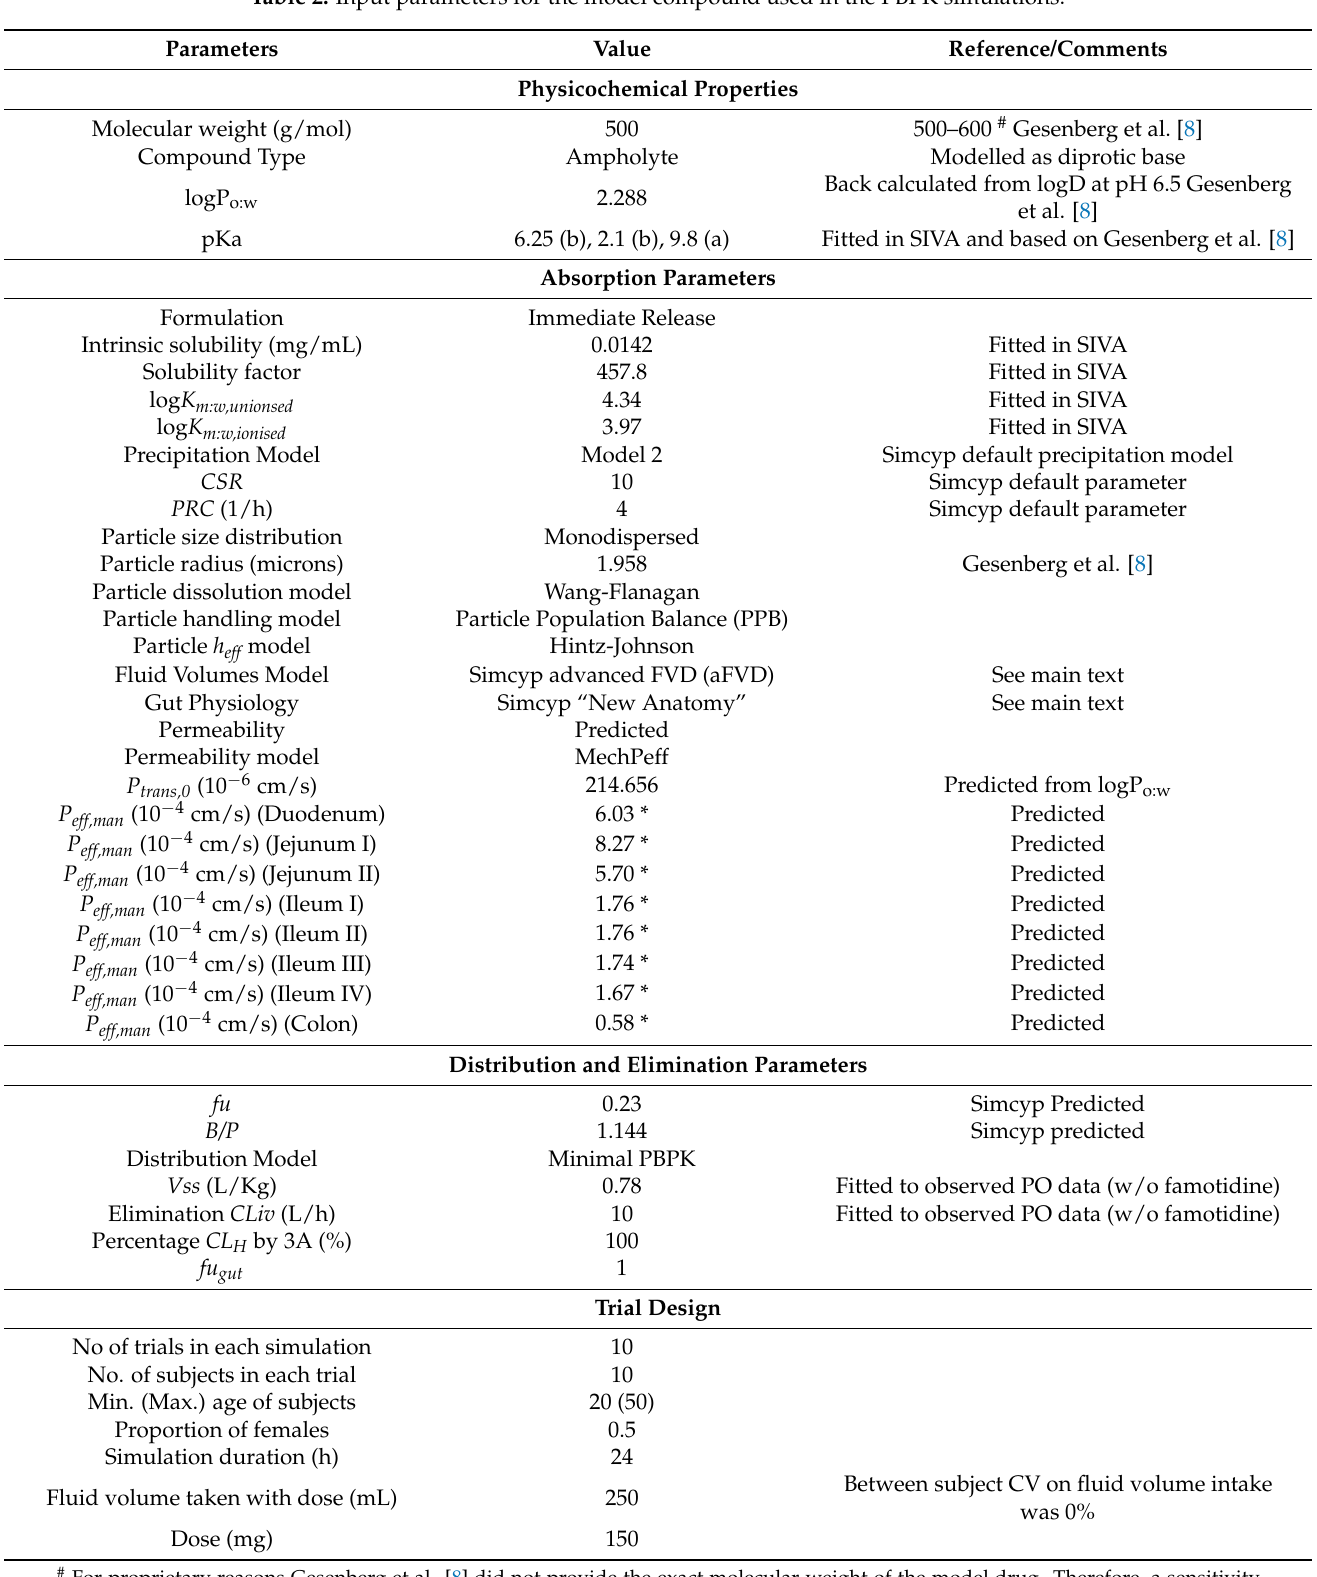
Table 2. Input parameters for the model compound used in the PBPK